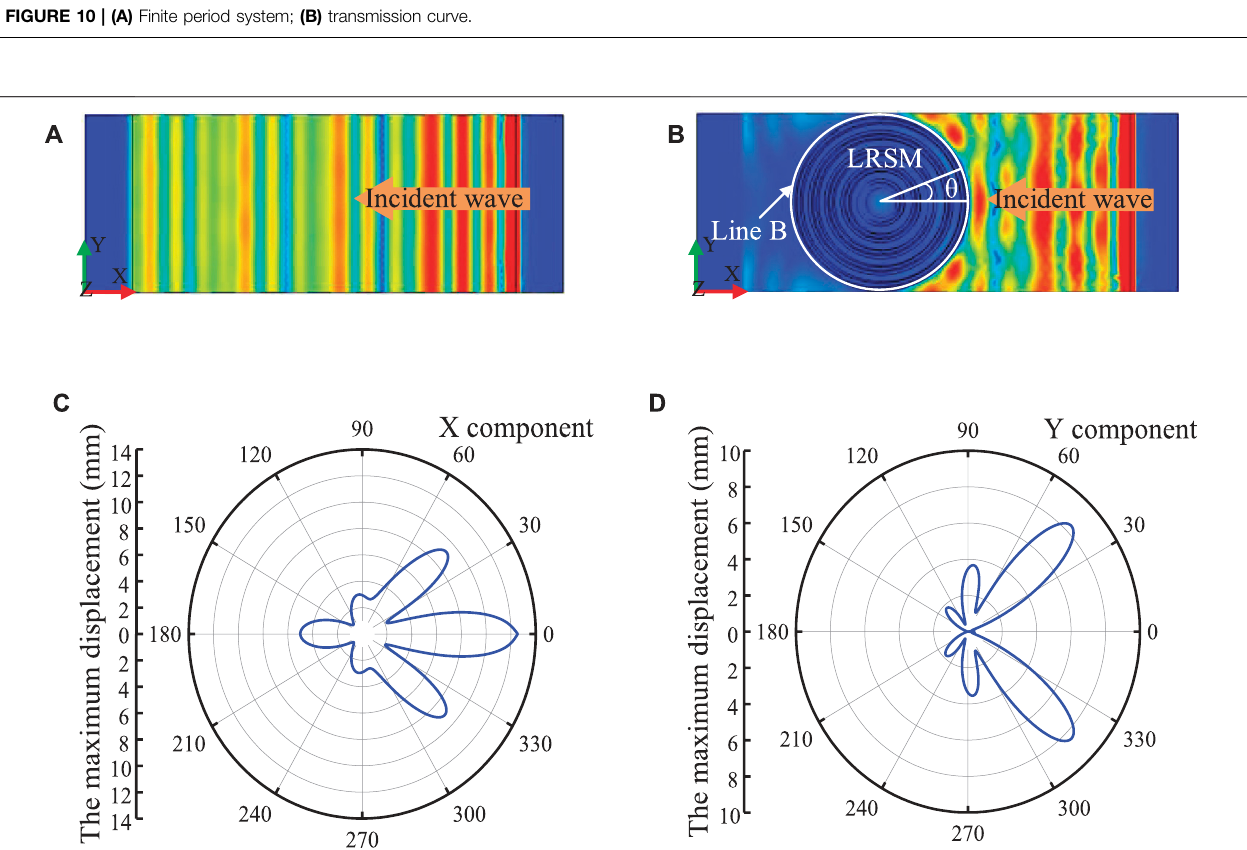
FIGURE 11 | Schematic diagram of surface wave propagation in XY plane: (A) Without LRSM; (B) with LRSM-2; (C) vibration displacement value of X component at line B; (D) vibration displacement value of Y component at line (B)